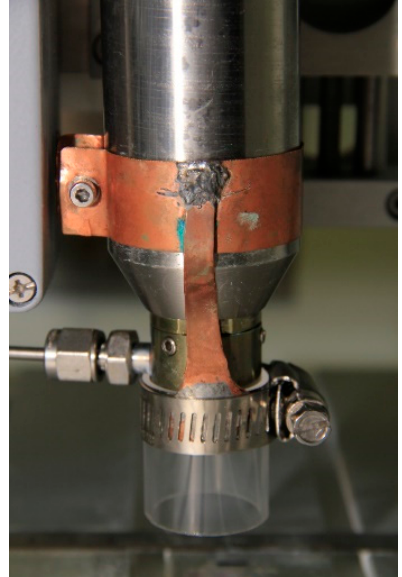
Figure 3. Plasma jet after modification with the quartz tube.